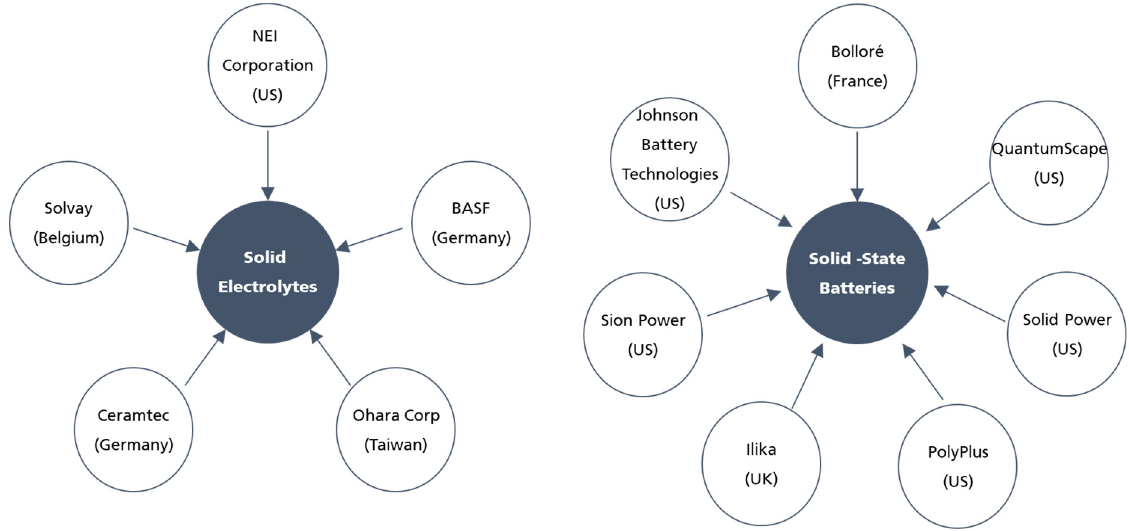
Figure 2. ASSB Market with key participants [74,75].